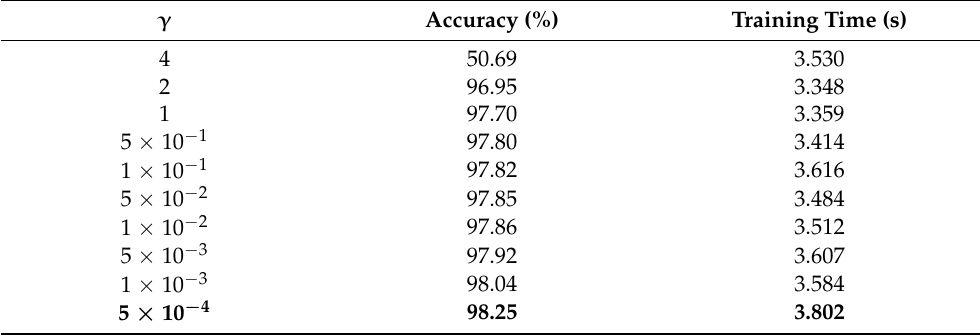
Table 5. The testing accuracies and training times for the different regularized indexes with l set at 6000.